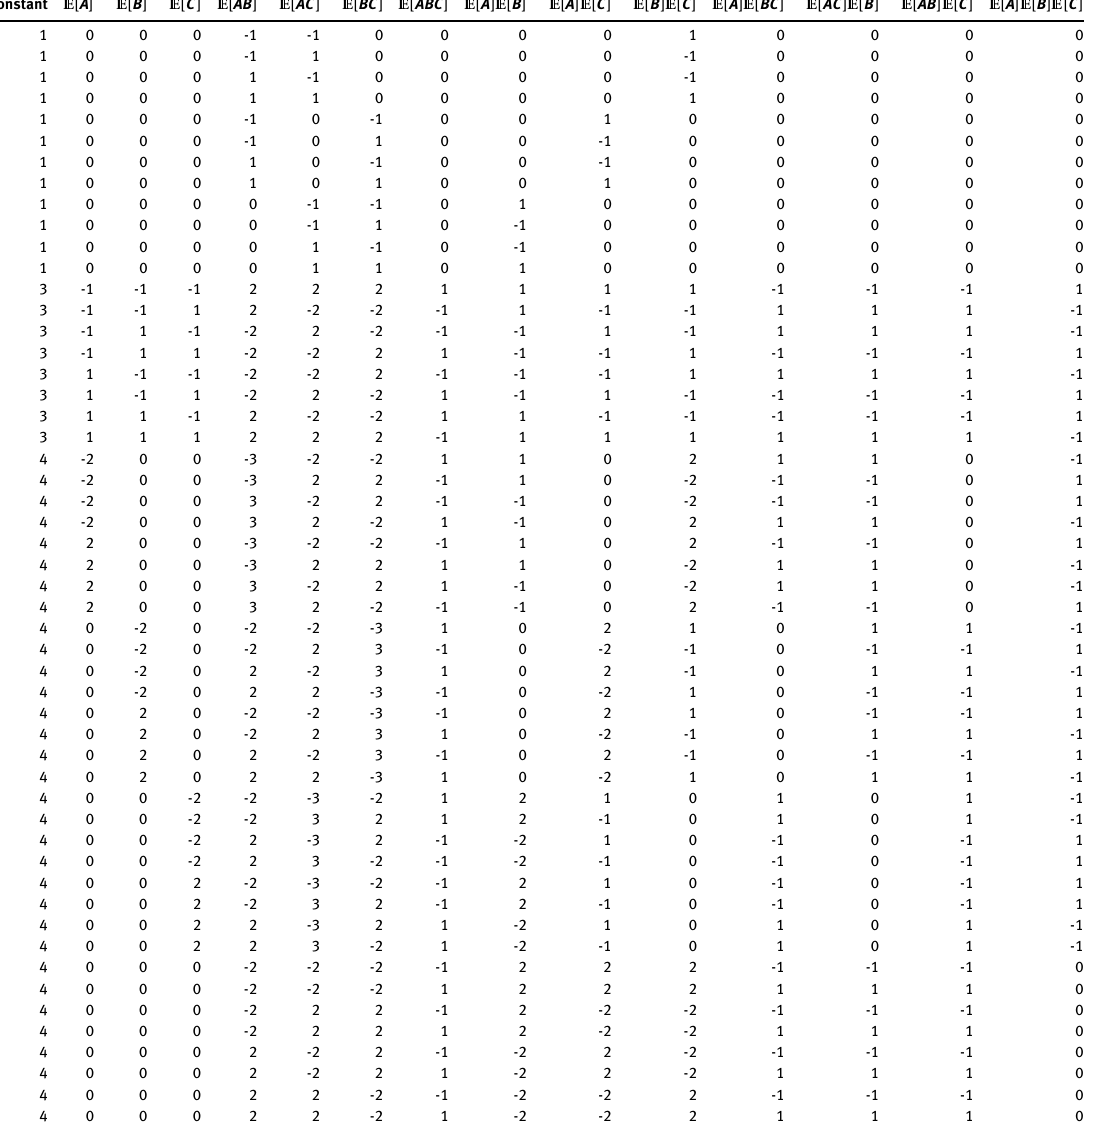
Table 2: A machine-readable and closed-under-symmetries version of the table in